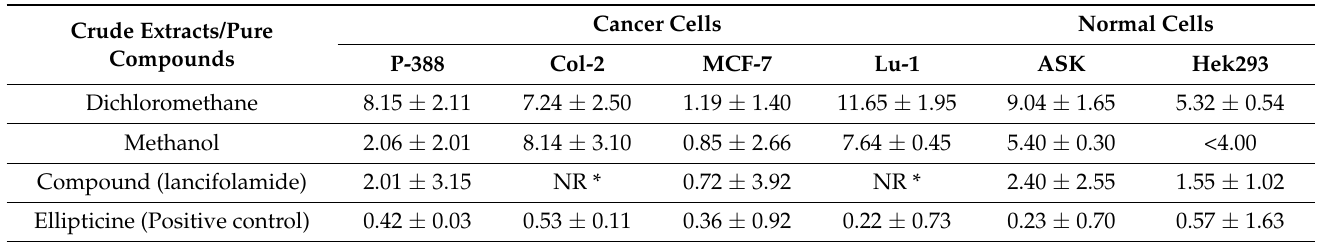
Table 5. Cytotoxicity of pure compounds or crude extracts from C. lancifolius. Mean ± SD (n = 3).